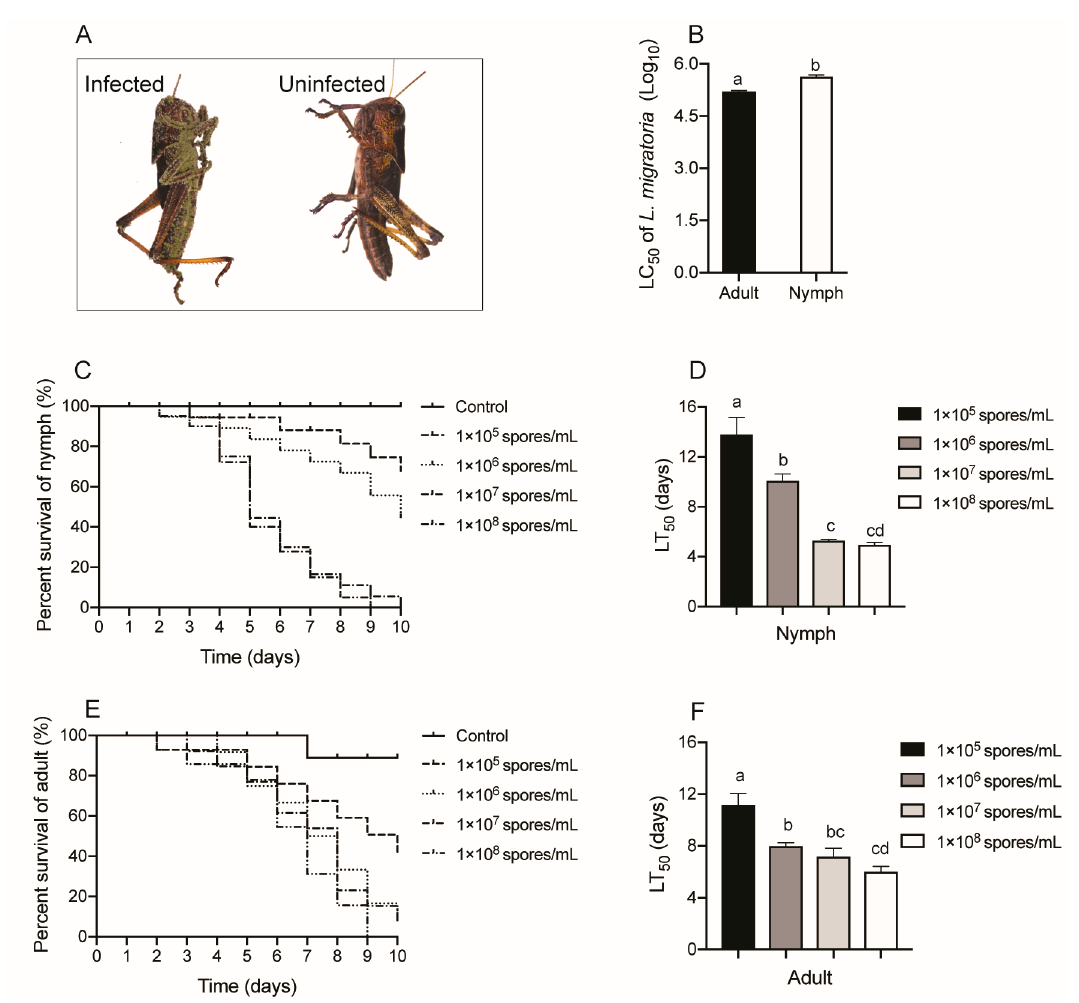
Figure 1. Survival of L. migratoria after exposure to M. anisopliae CQMa421. ( A ) the corpses of L. migratoria insects infected with M. anisopliae CQMa421 or not; ( B ) LC 50 of L. migratoria adults and nymphs; ( C ) Survival rate of L. migratoria nymphs treated with M. anisopliae CQMa421; ( D ) LT 50 of L. migratoria nymphs after being challenged with M. anisopliae CQMa421. ( E ) Survival rate of L. migratoria adults treated with M. anisopliae CQMa421; ( F ) LT 50 of L. migratoria adults after being challenged with M. anisopliae CQMa421. The different letters indicate significant differences, and the bars represent the means ± SEs.